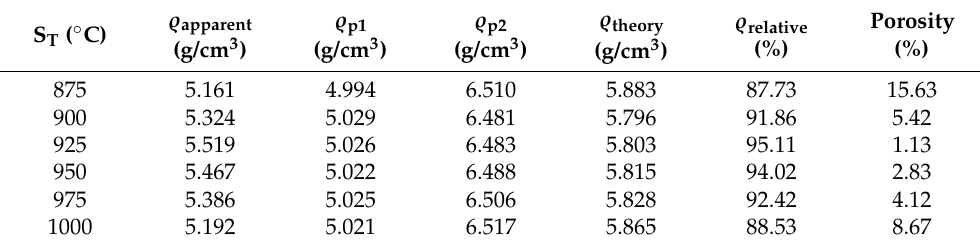
Table 3. The apparent density, theory density, relative density and porosity of MgCu 2 Nb 2 O 8 ceramics sintered at different